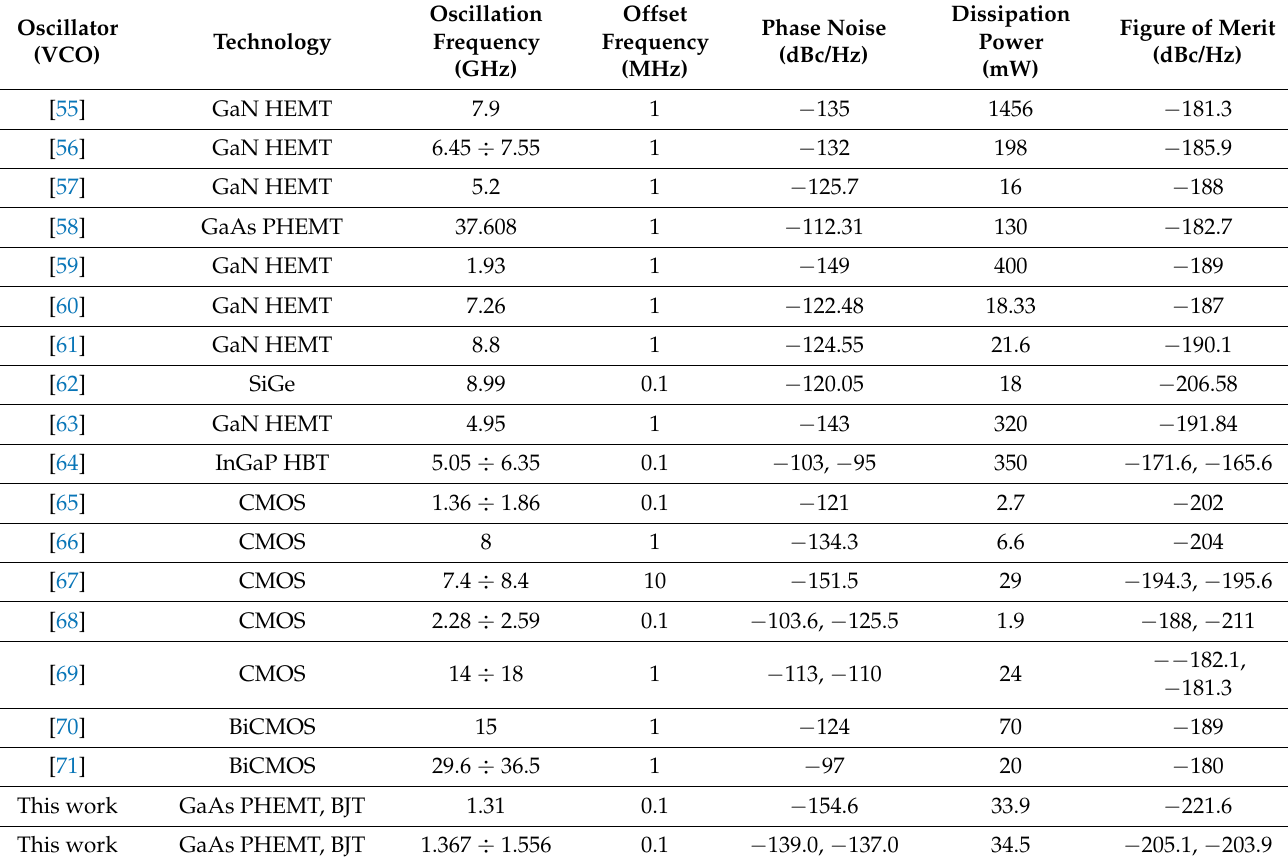
Table 14. Comparison of designed and some recently published microwave oscillators.